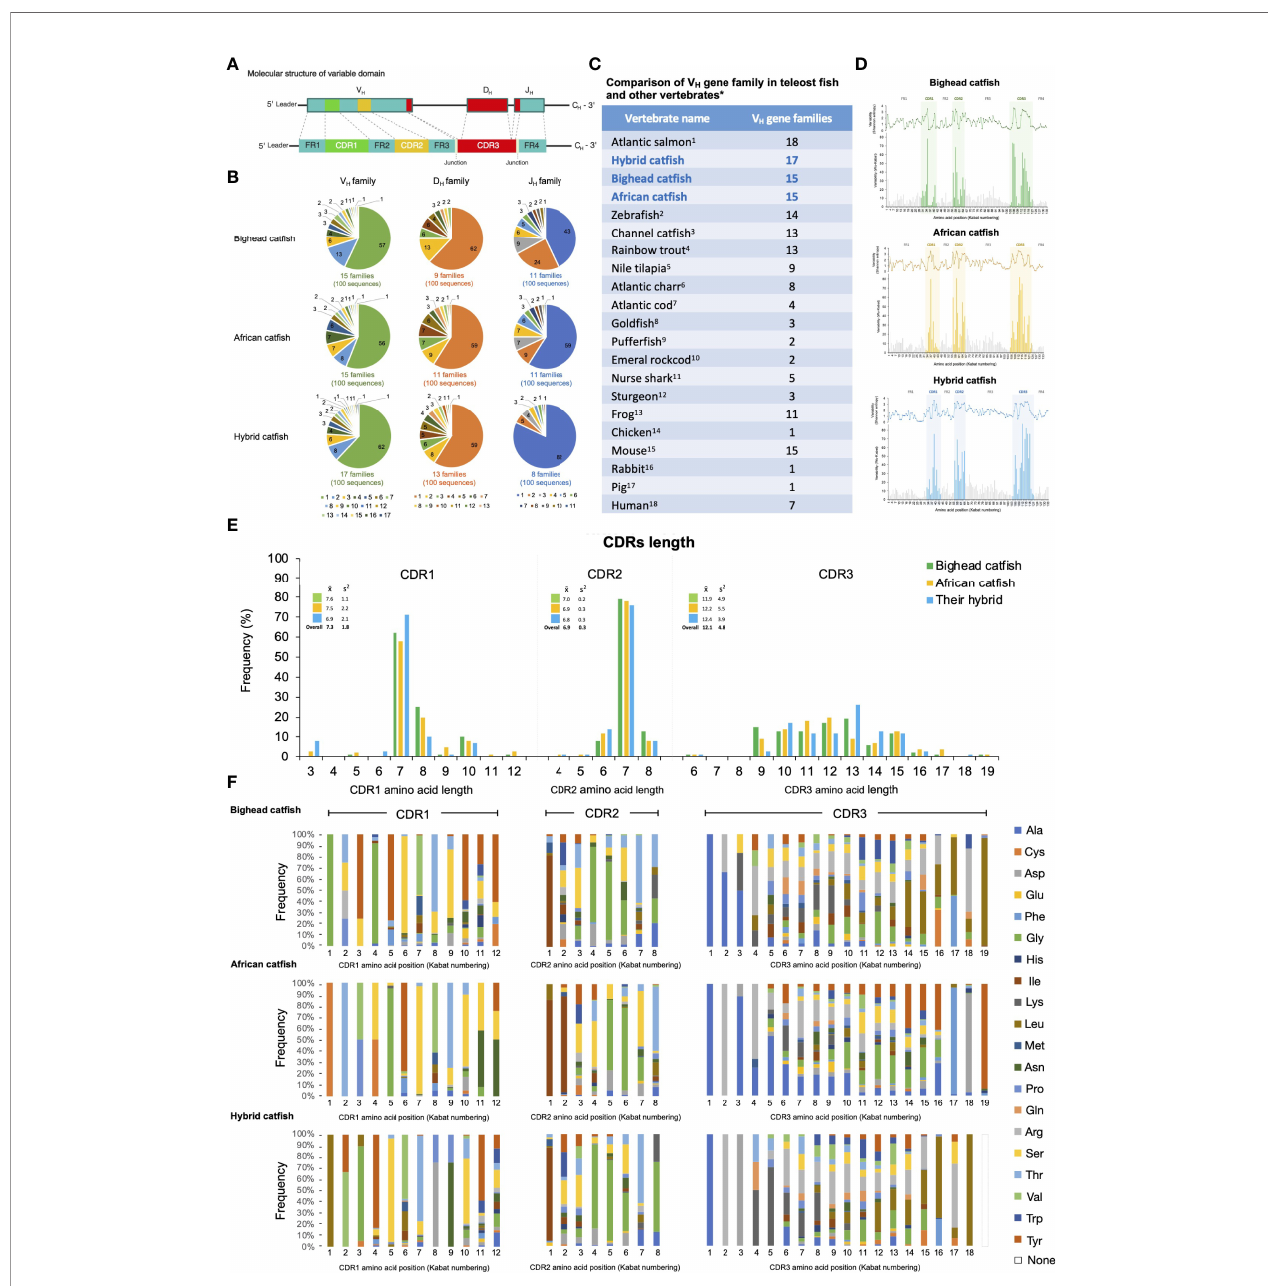
FIGURE 5 | Representation of comparative diversity analyses of the VH domains of Igh m bighead cat fi sh, North African cat fi sh and their hybrid cat fi sh. General structures of the VH domain correspond to the V H , D H , and J H segments that consist of the FR1, CDR1, FR2, CDR2, FR3, CDR3 and FR4 regions found in all vertebrates (A) . Comparative classi fi cation of the V H , D H , and J H gene segments in bighead cat fi sh, North African cat fi sh and their hybrid cat fi sh (B) . Comparison of V H gene family members among reported vertebrates (C) . Degree of sequence variability of the VH repertoire in bighead cat fi sh, North African cat fi sh and their hybrid cat fi sh, according to the Shannon (1948) and Kabat and Wu (1971) methods (D) . Comparison of amino acid length in CDR1, CDR2, and CDR3 of bighead cat fi sh, North African cat fi sh and their hybrid cat fi sh (E) , x ̅ : average nucleotide length, S 2 : variance distribution. Percent frequency of amino acid variability and composition of CDR1 CDR2 and CDR3 regions of bighead cat fi sh, North African cat fi sh and their hybrid cat fi sh (F) . The NCBI accession numbers of VH nucleotide sequences are MN934442- MN934541, MN934542- MN934641 and MN934642- MN934741 for bighead cat fi sh, North African cat fi sh and their hybrid cat fi sh, respectively. 1 Yasuike et al., 2010 (44); 2 Danilova et al., 2005 (13); 3 Yang et al., 2003 (45); 4 Brown et al., 2006 (46); 5 Phuyindee et al., 2015 (47); 6 Andersson and Matsunaga, 1998 (48); 7 Stenvik et al., 2000 (49); 8 Wilson et al., 1991 (31); 9 Peixoto and Brenner, 2000 (50); 10 Coscia and Oreste, 2003 (22); 11 Rumfelt et al., 2004 (51); 12 Lundqvist et al., 1998 (52); 13 Haire et al., 1990 (53); 14 Ota and Nei, 1995 (54); 15 Mainville et al., 1996 (55); 16 Mage et al., 1984 (56); 17 Sun et al., 1994 (57) and 18 Matsuda et al., 1998